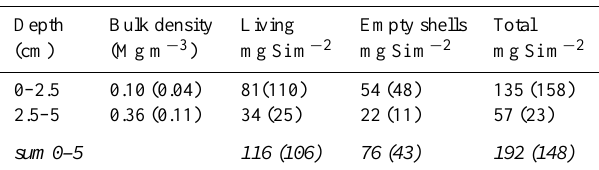
Table 3. Si pools of idiosomic testate amoebae; mean values and standard deviation (in brackets), n = 5 field